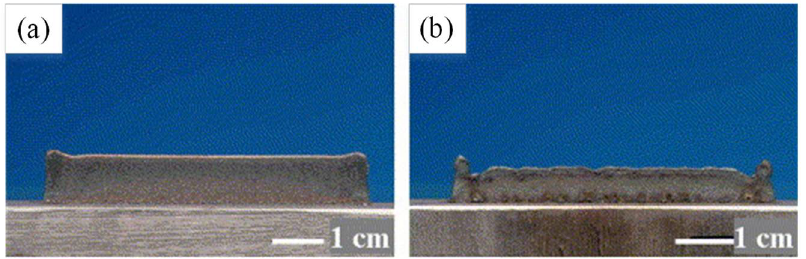
Figure 2. The 316L thin-wall fabricated by LMD with z-increment of ( a ) 0.15 mm and ( b ) 0.25 mm (Reprinted from ref. [32], copyright (2006), with permission from Elsevier). Table 2. Maximum values of 316L thin-walled parts’ top surface unevenness measured with different laser defocusing distances (D l ) and powder defocusing distances (D p )